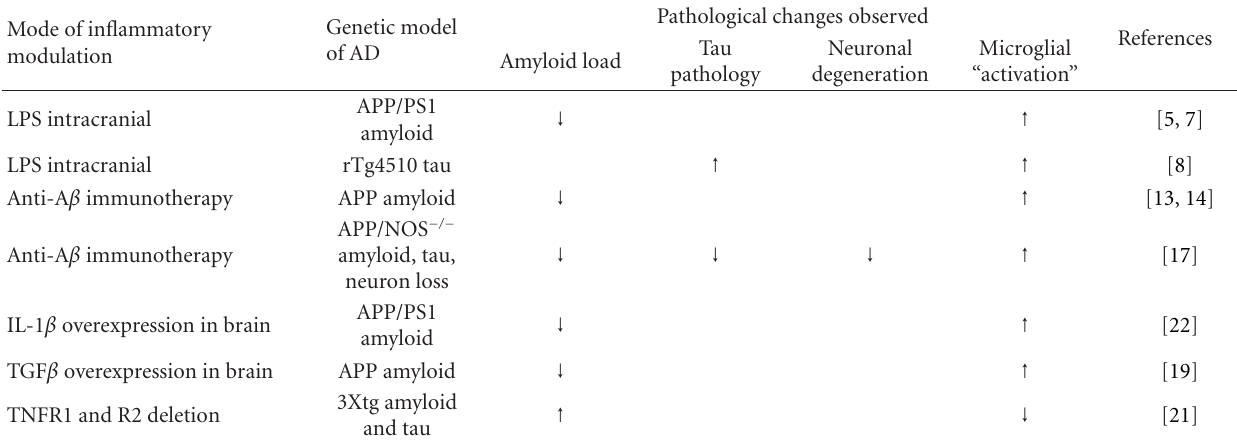
Table 1: Summary of some transgenic mouse studies that have modulated inflammation and the e ff ects these modulations had on the